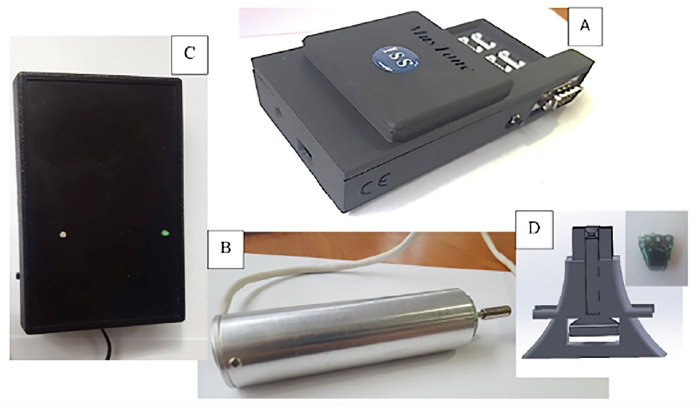
Figure 1. MusTone Device components: ( A ) data-processing unit, ( B ) impulse applicator, ( C ) power supply, and ( D ) accelerometers.